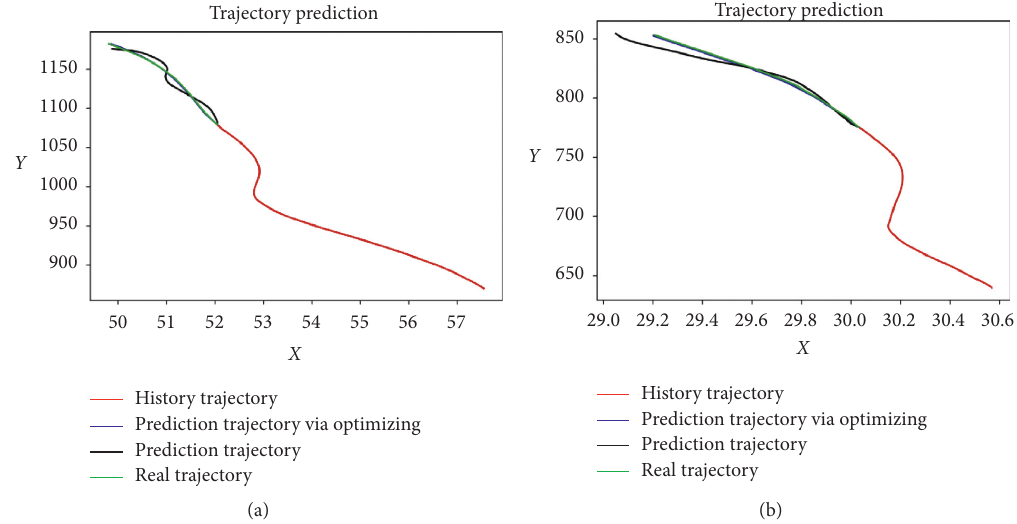
Figure 8: Trajectory prediction results using the two models in the series. (a) Prediction trajectory 1. (b) Prediction trajectory 2.